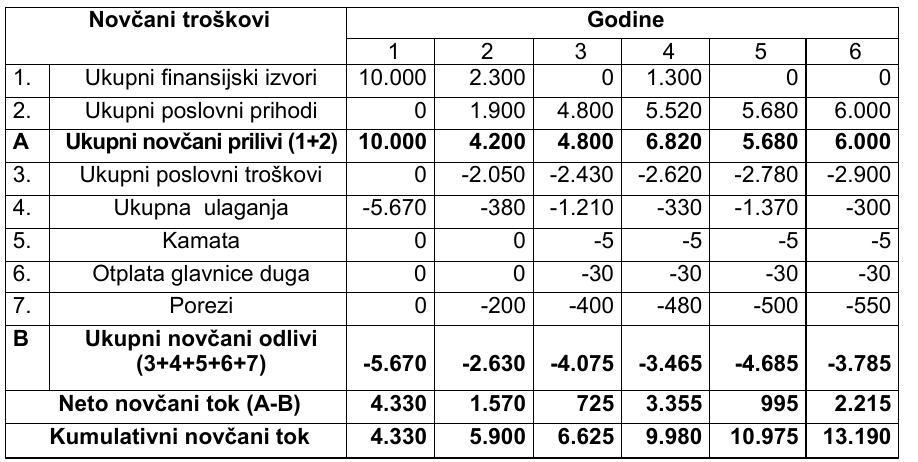
Finansijska održivost (u 000 din, teku ć e